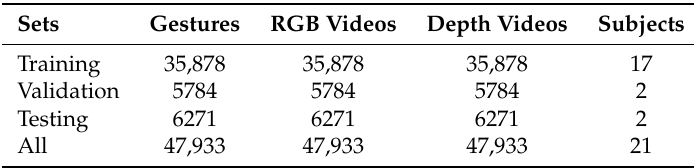
Table 8. Information of the ChaLearn LAP IsoGD